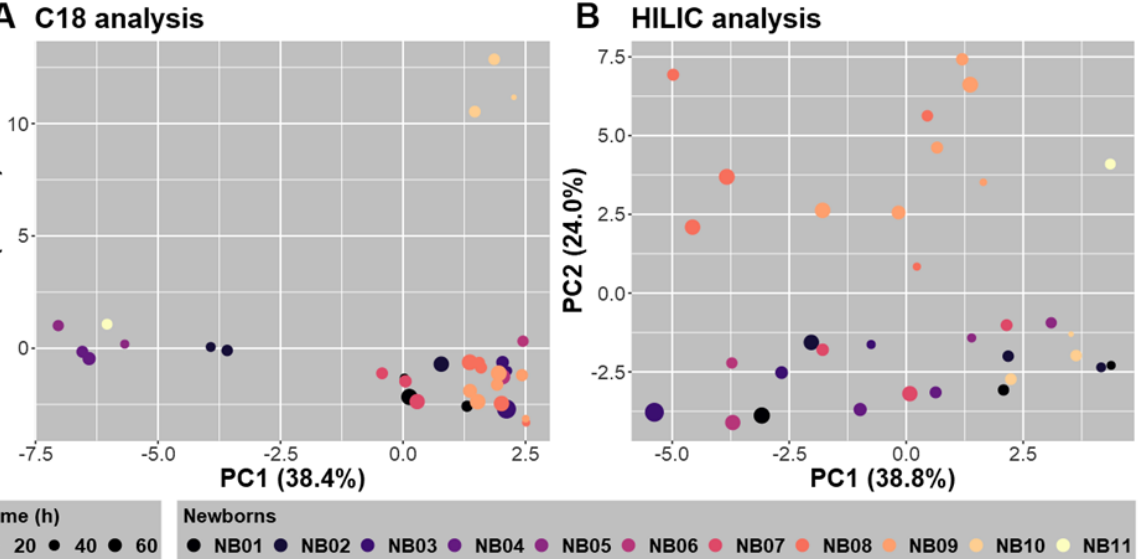
Figure 4. Canonical analyses between all relevant features obtained in C18-ESI + (( A ) 8555 features) and HILIC-ESI − (( B ) 6843 features) LC-HRMS conditions, and a dummy matrix summarizing feces samples collected for the different newborns (NBs) completed with the time date (expressed in hours, h) of sample collection.